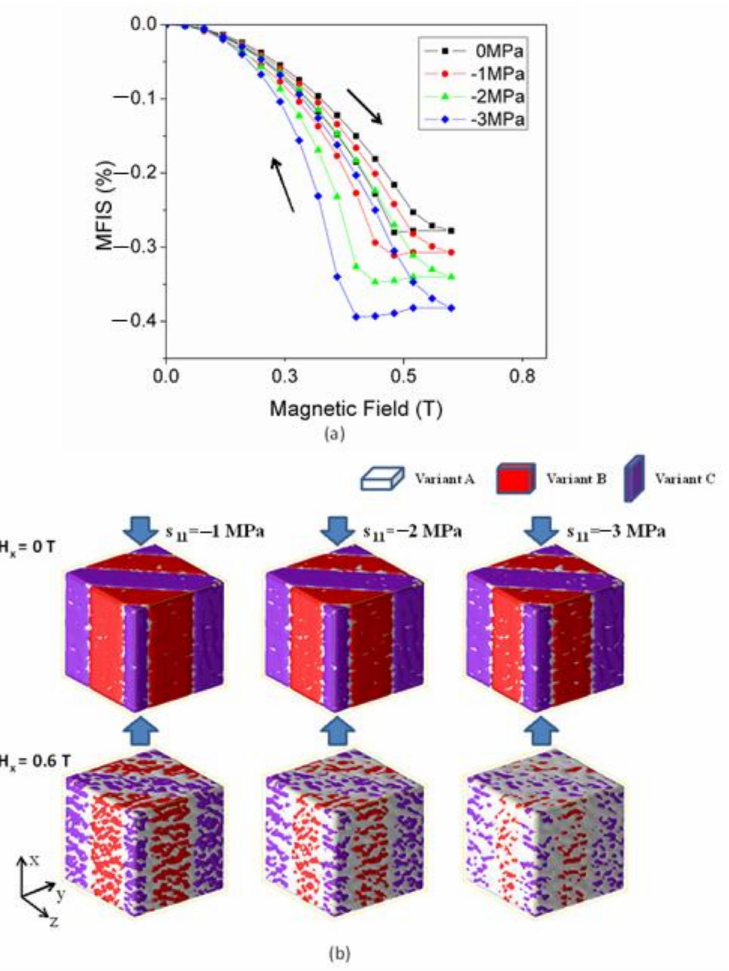
Figure 4. ( a ) MFIS loops with different applied compressive stress (along the x -axis) at 285 K; ( b ) simulated martensite variants at H x = 0 T and H x = 0.6